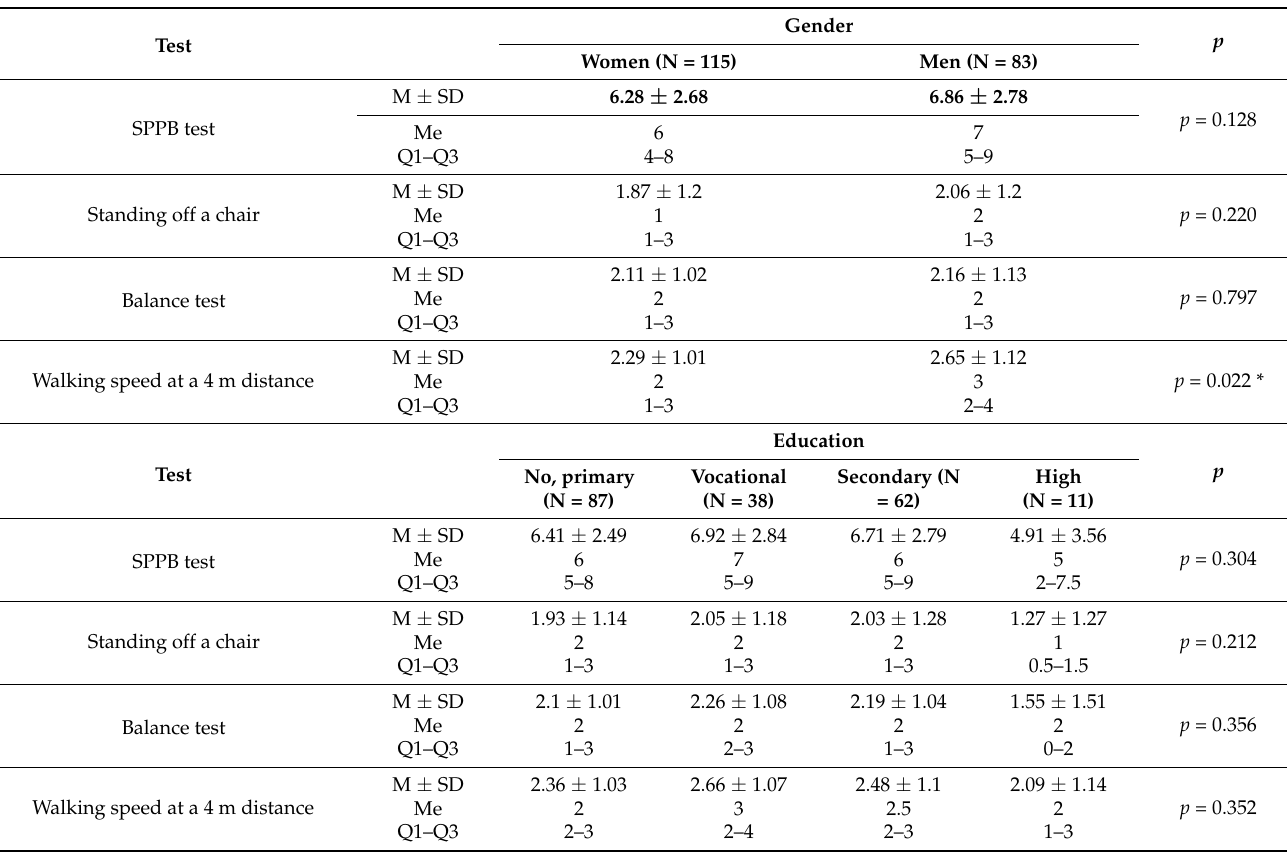
Table 4. Statistical characteristics of the SPPB test results in correlation to gender, education, prior work and level of physical